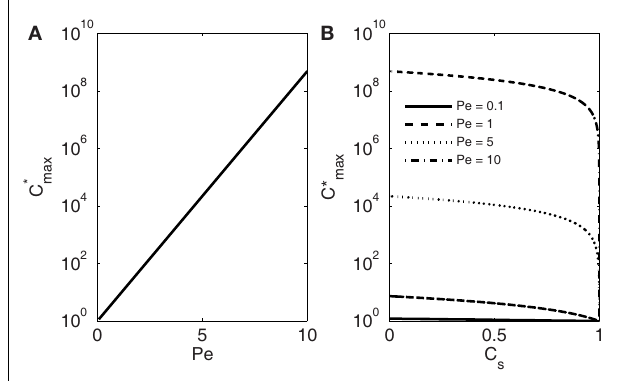
FIGURE 2 | Dependence of the maximum solute concentration obtained during freezing ( C ∗ ; Eq. 17) on Pe (A) and C S (B). In (A) the max solute solubility in ice/solubility in water C S is 0.001.The maximum concentrations are always obtained at the ice-water interface (see Figure 1 ). If the solubility in ice is less than half of the solubility in water ( C S < 0.5) the maximum concentration depends only slightly on C S . Because of the molecular size, C S for solutes present in xylem sap is well below